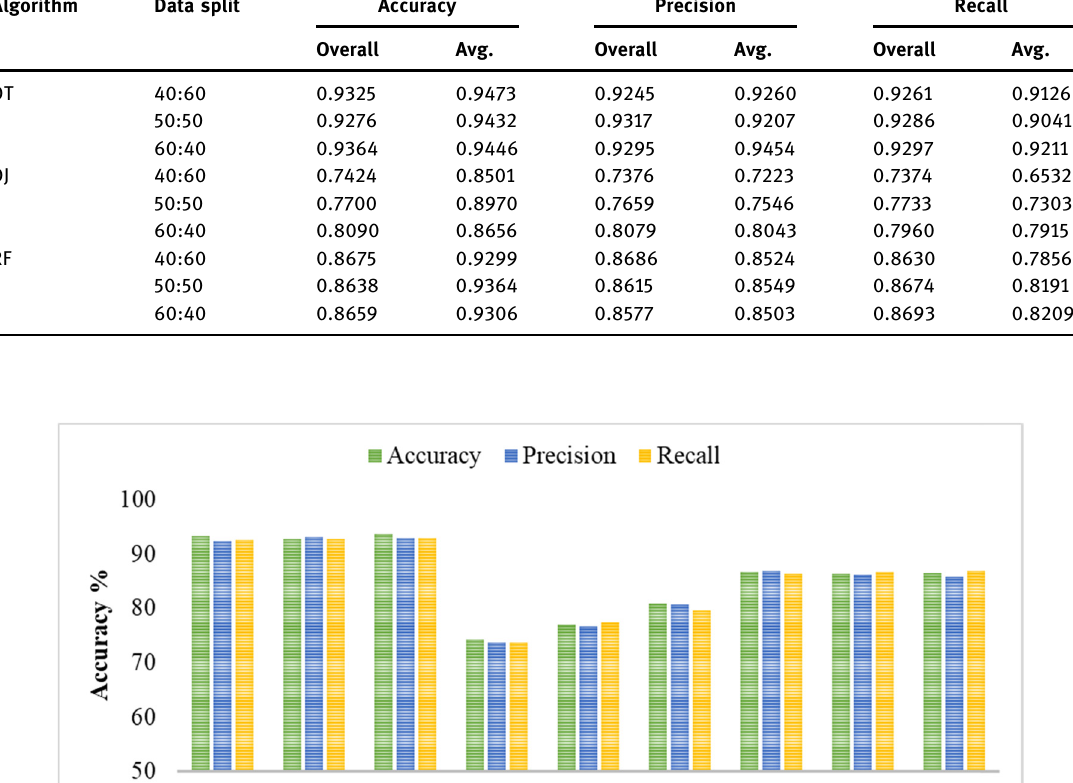
Table 2: The results of the IoT - FSP model Algorithm